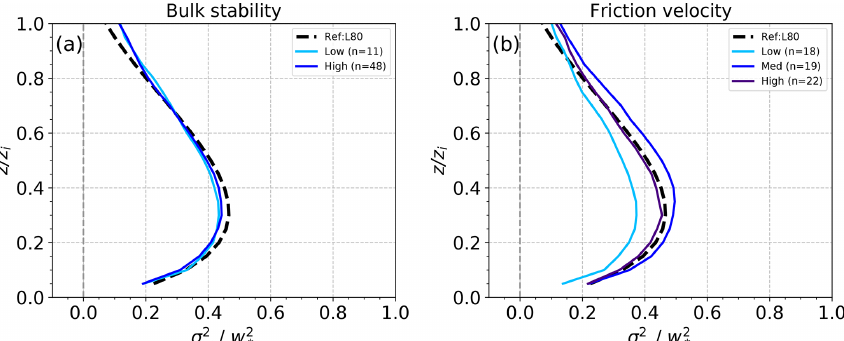
Figure 13. Classification of σ 2 w /w 2 ∗ based on the (a) bulk stability and (b) friction velocity. In the legend, n indicates the number of days in each